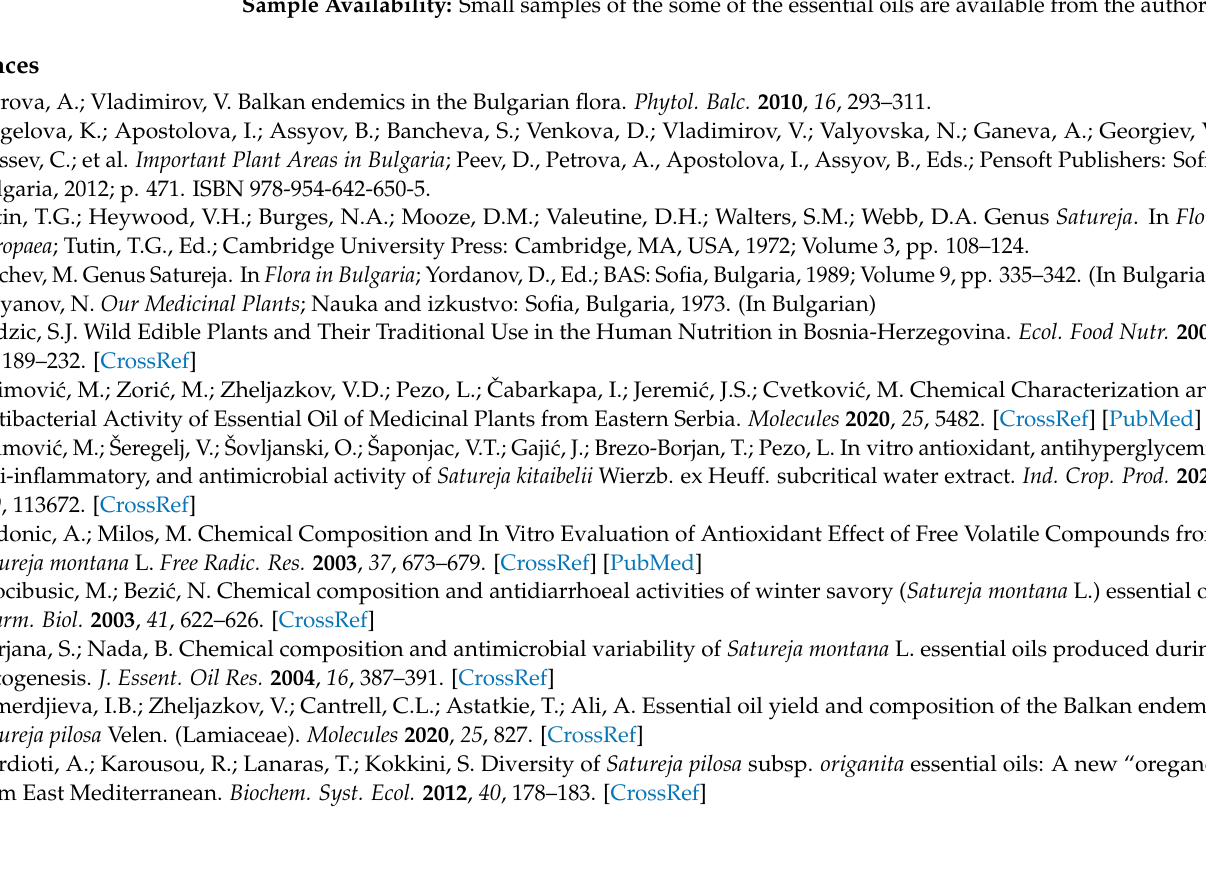
Table S2: Constituents and concentrations of S. kitaibelii ( S. montana subsp. kitaibelii) populations in Bulgaria and Serbia. Table S3: Locality, coordinates and used samples in population of Satureja pilosa and S. kitaibelii in Bulgaria and